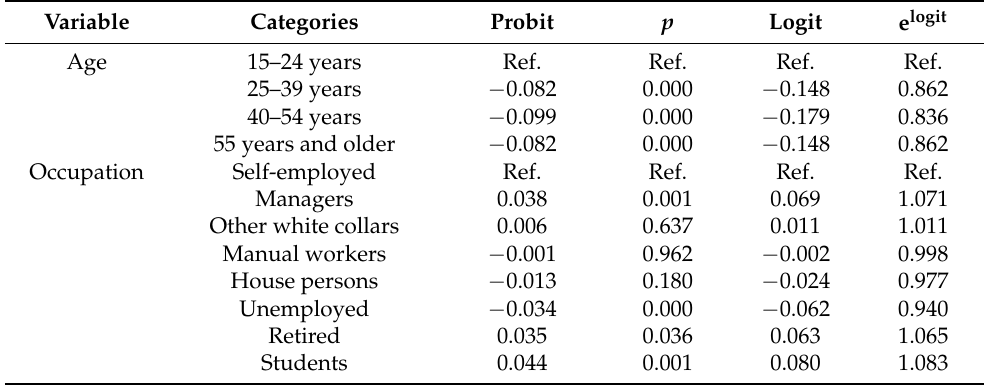
Table 2. Vaccine uptake